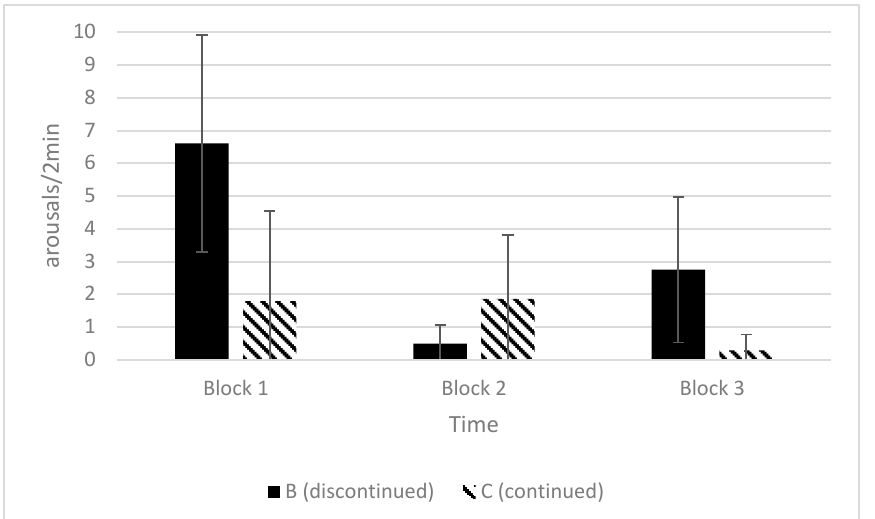
Figure 4. Average (±SD) rate of low-intensity arousals per 2 min calculated for the first three time blocks in the calves for which the squeezed was maintained for the full 10-min period (Category C, n = 7) and the calves for which the squeeze was discontinued due to high-intensity arousal (Category B, n = 4). The duration of the first time block varied among the individual calves depending on how long it took for the calf to be induced and, as a result, was less than 2 min for some individuals. Blocks 2 and 3 were both two minutes long in all of the calves.